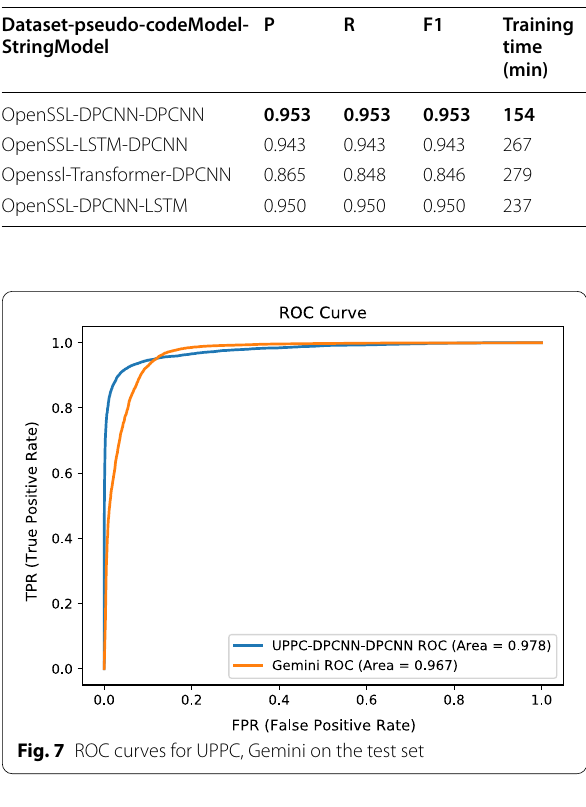
2 Kam1n0 is a scalable assembly management and analysis platform: https:// github. com/ McGill- DMaS/ Kam1n0- Commu